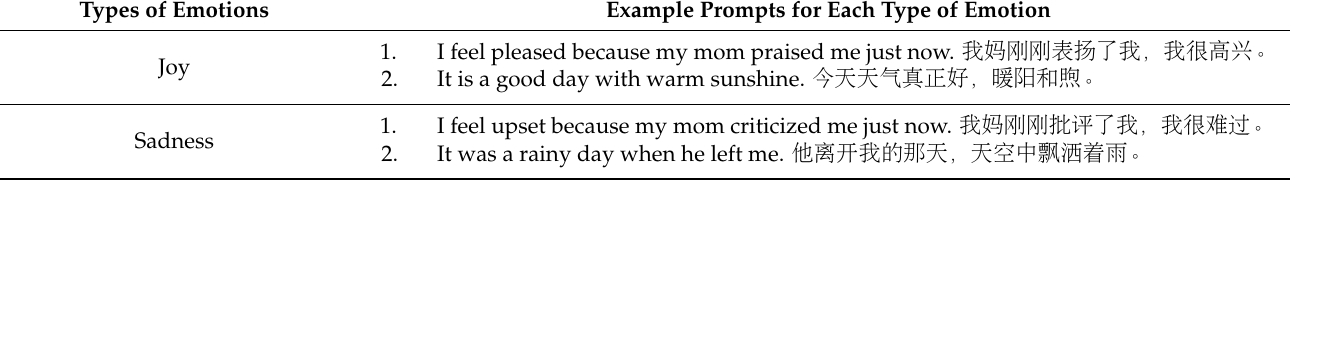
Table A1. Example prompts for each type of emotion (Emotional Reading Span Task). Types of Emotions Example Prompts for Each Type of